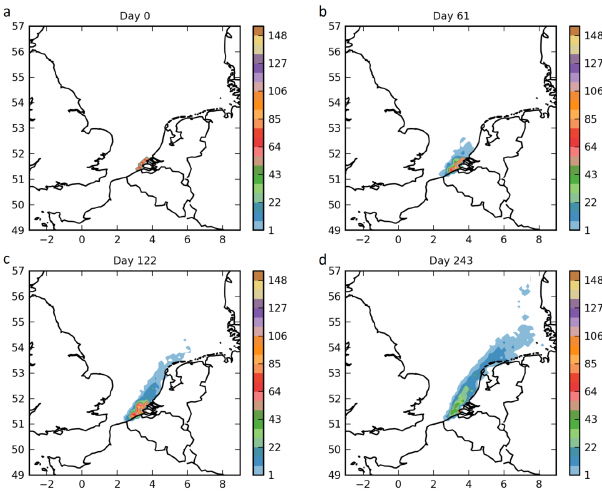
Figure 7. Density of simulated M. leidyi individuals on the model grid (number of individuals per grid cell) for releases in the rivers Seine and Somme. (a) on day 1 of the simulation (1 June 2008); (b) on day 61 (31 July 2008); (c) on day 121 (29 September 2008); (d) on day 240 (25 January